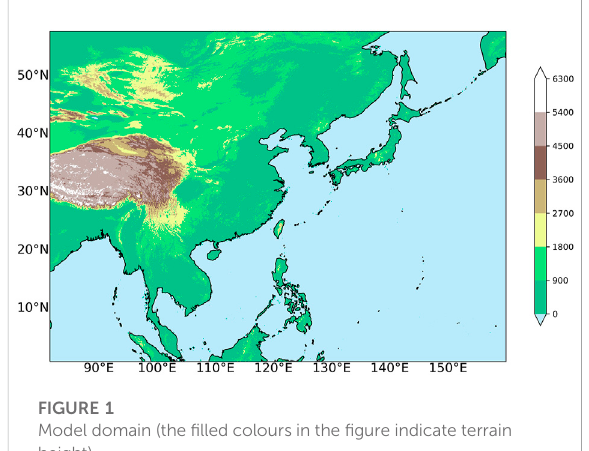
FIGURE 1 Model domain (the fi lled colours in the fi gure indicate terrain